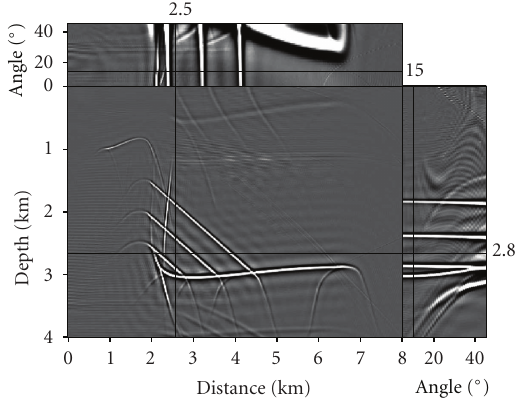
Figure 7: Migrated section after DTI-based migration with velocity of 2km/s and η = 0 . 2 of the TTI synthetic data in Figure 4. The angle gathers obtained, now, using the VTI mapping at 2.5km location are displayed on the right. The top section shows a depth slice as a function of angle gather at depth 2